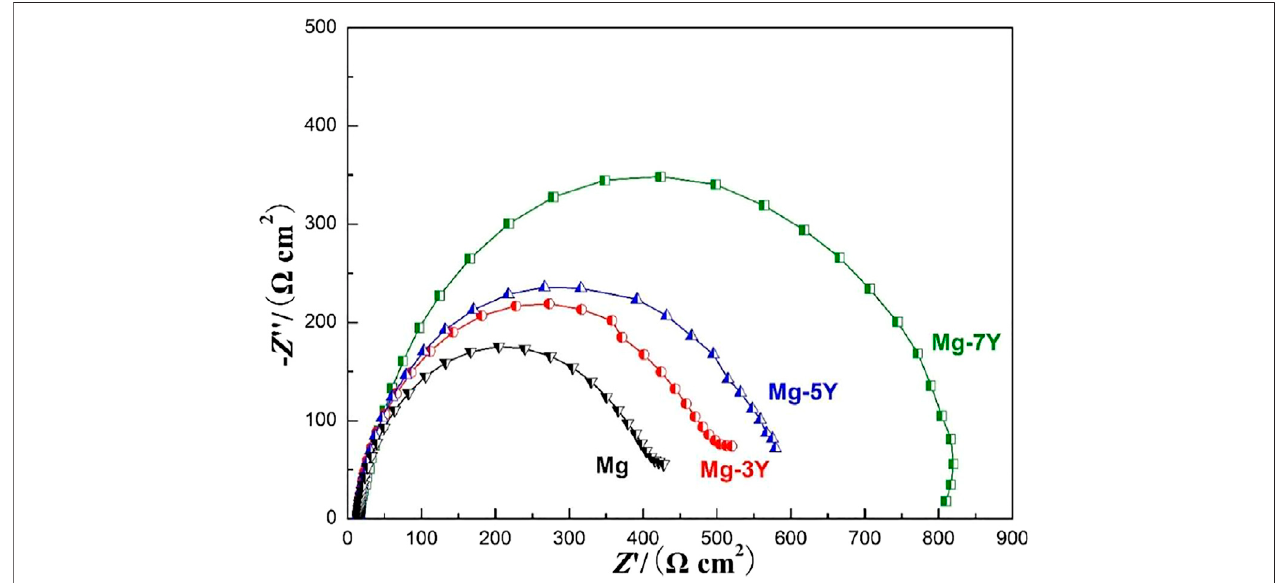
FIGURE 7 | The electrochemical impedance spectra curves of samples covered with oxidation fi lms in the surface measured in 3.5% NaCl solution.